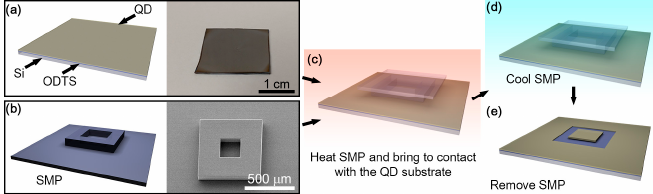
contacting the QD substrate, resulting in successful